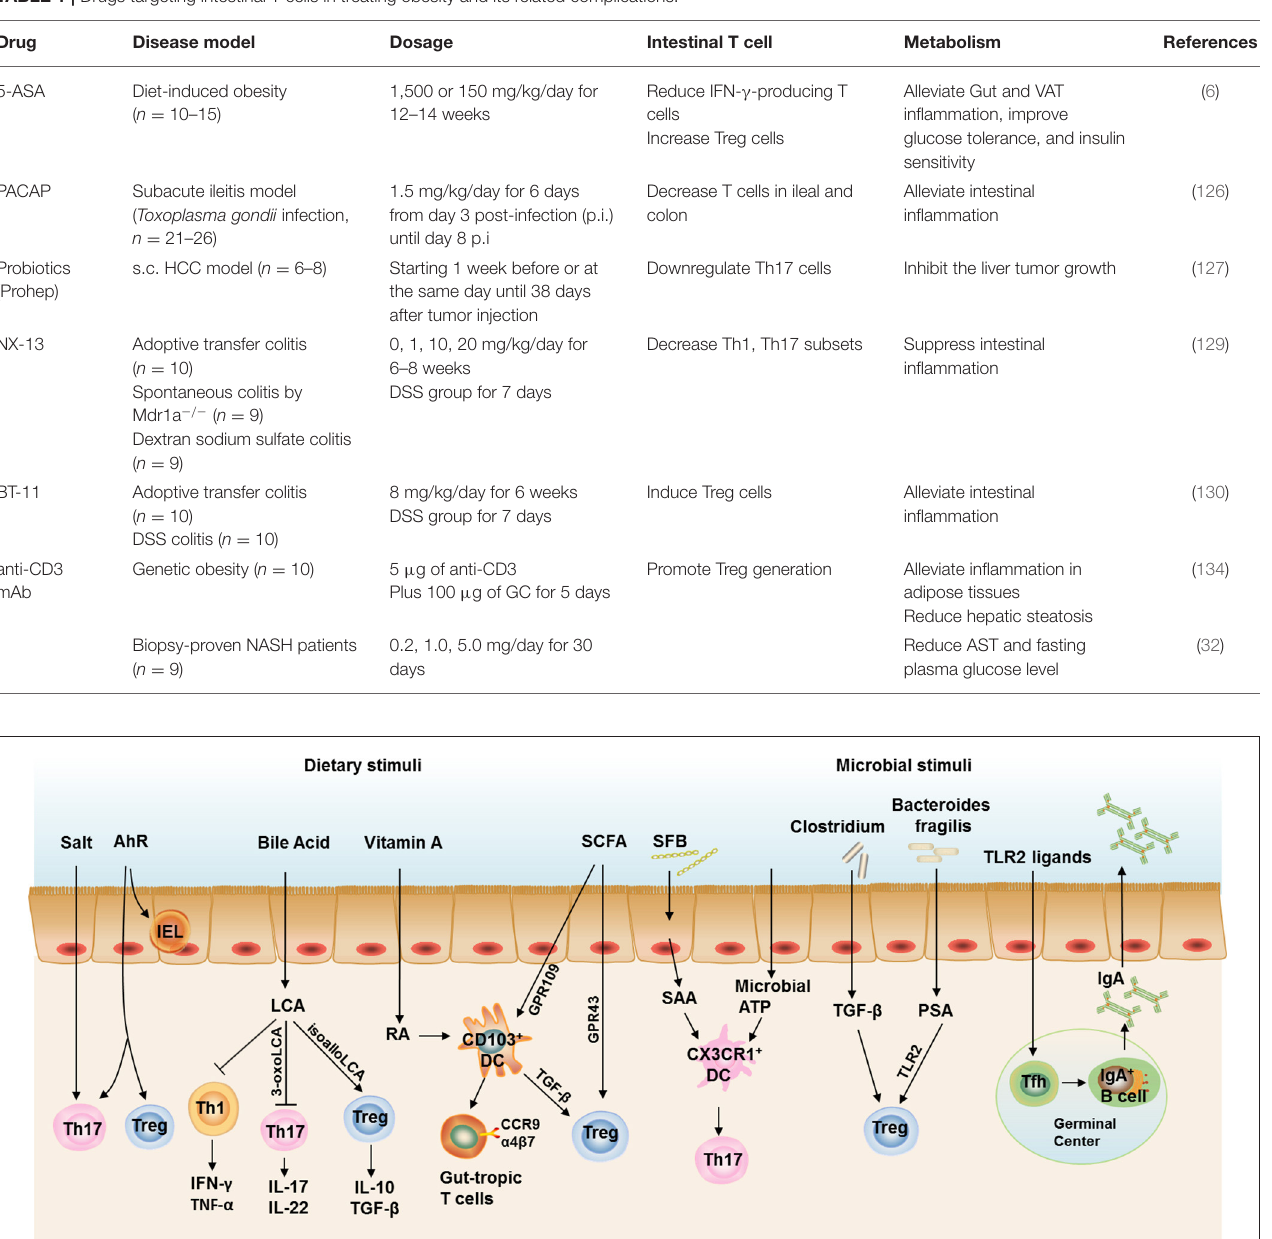
Frontiers in Immunology |